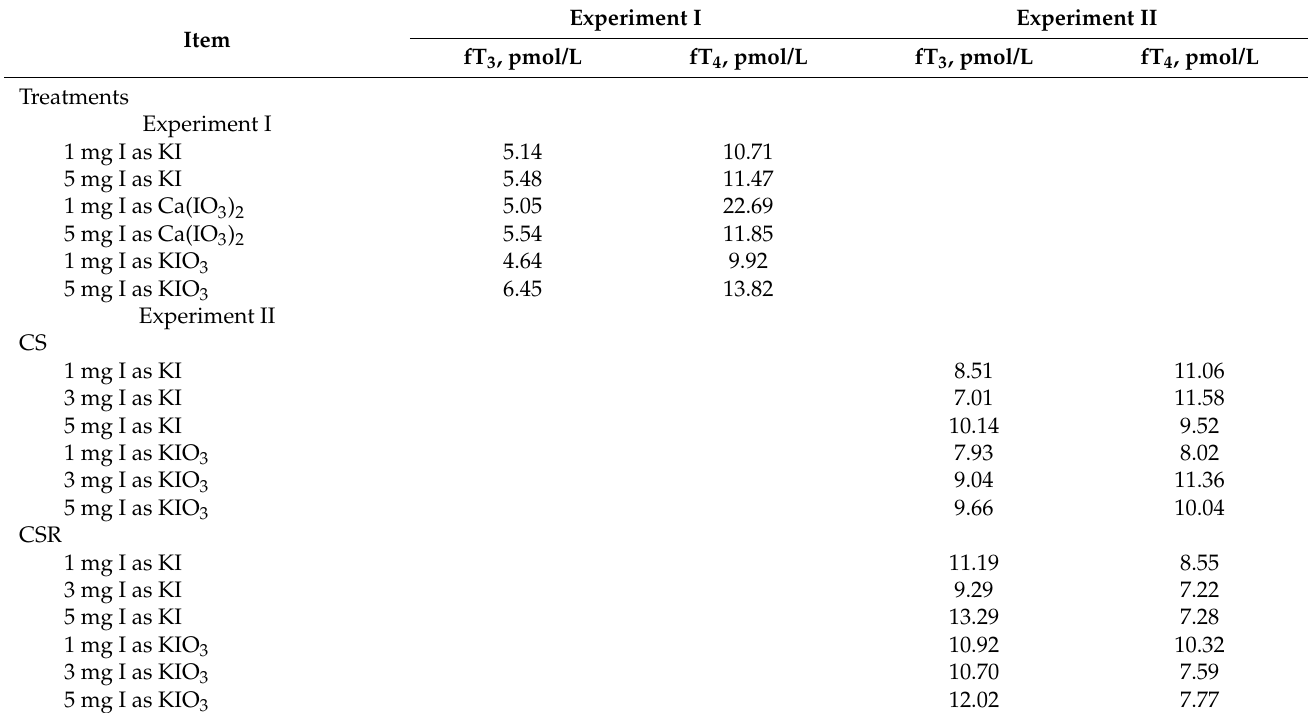
Table 3. Thyroid hormone concentration in hen blood serum (Exp. I and Exp.